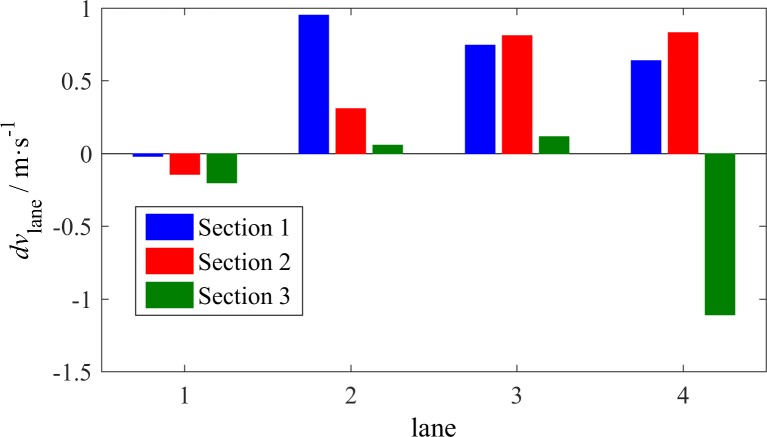
Average dvlane that corresponds to LC vehicles in each lane.